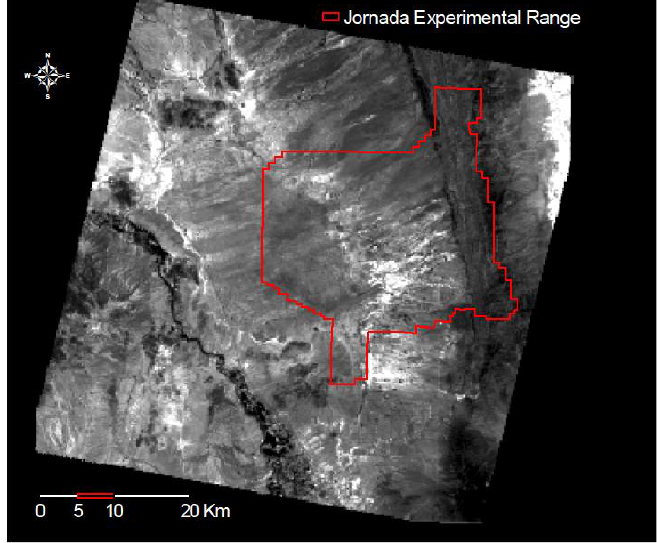
Figure 1. ASTER surface reflectance VNIR band 3N over Las Cruces area on 08 June